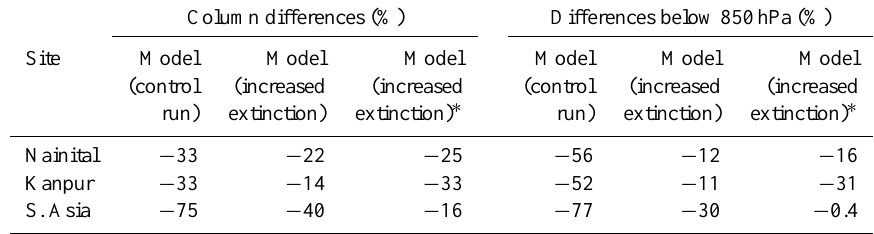
Table 1. Estimated differences relative to CALIPSO extinction profiles for Nainital, Kanpur, and South Asia in March 2012. Column differences (%)